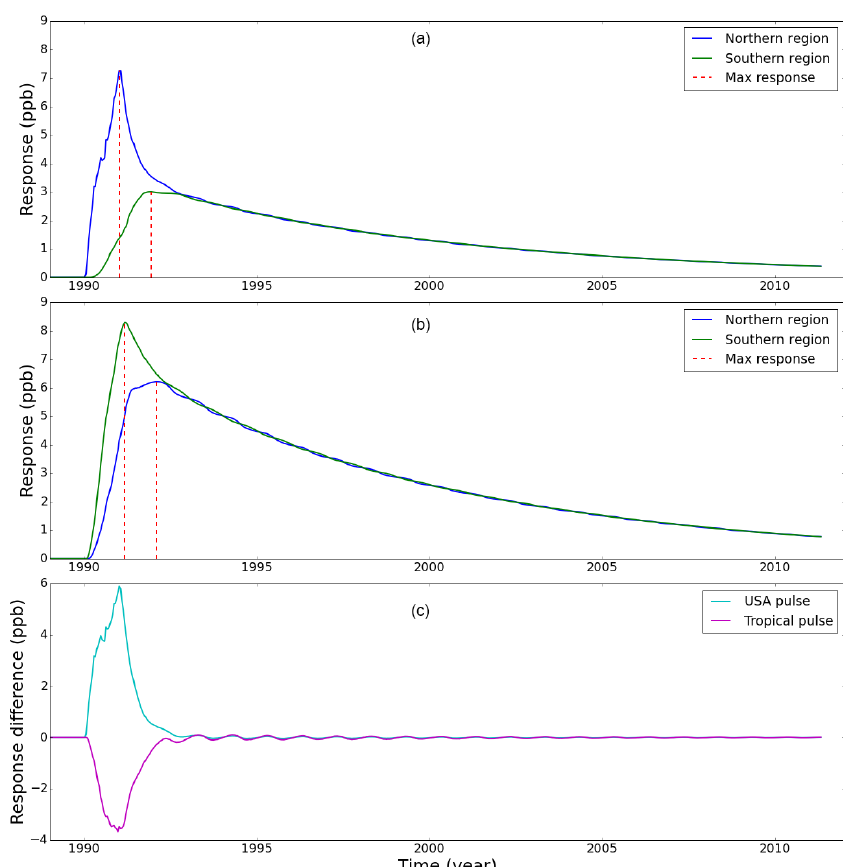
Figure 2. The model response of atmospheric CH 4 mole fraction sampled at northern and southern polar regions to a pulsed emission at (a) mid-latitude USA and (b) the tropics. Panel (c) shows the IPD response to these mid-latitude and tropical perturbations. In the interest of clarity, we omit error bars from the plots. Vertical red dashed lines denote the peak response time for each polar